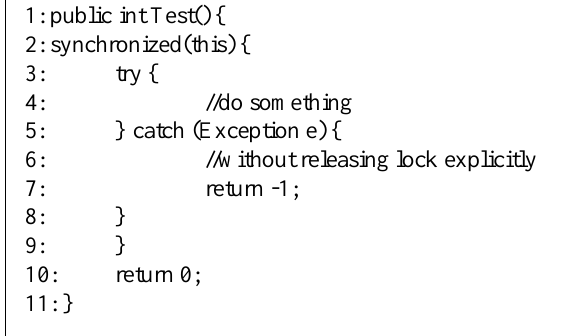
Figure 3. The sample code of scoped locks in